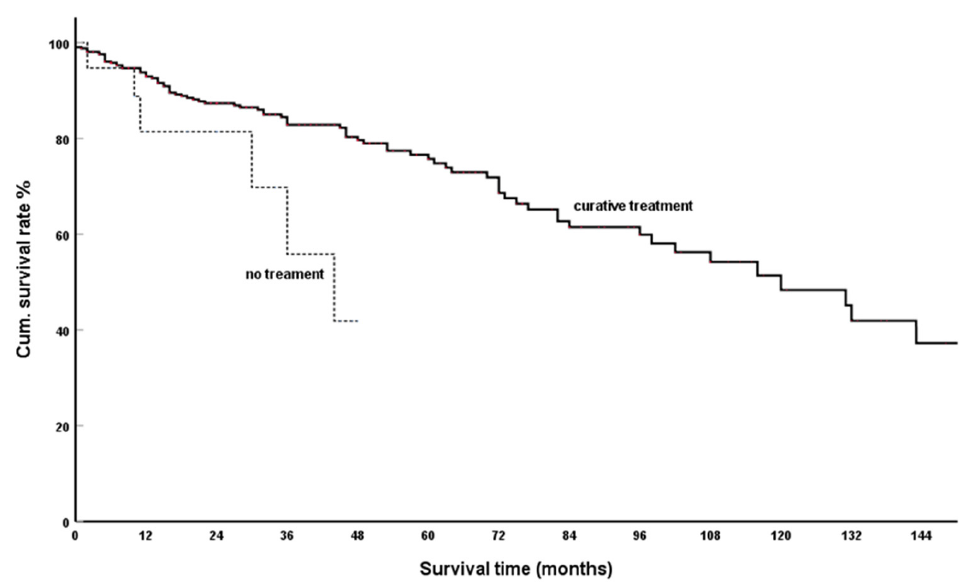
Figure 2. Surgical treatment vs. non-treatment group; Kaplan-Meier survival curves ( p = 0,013).